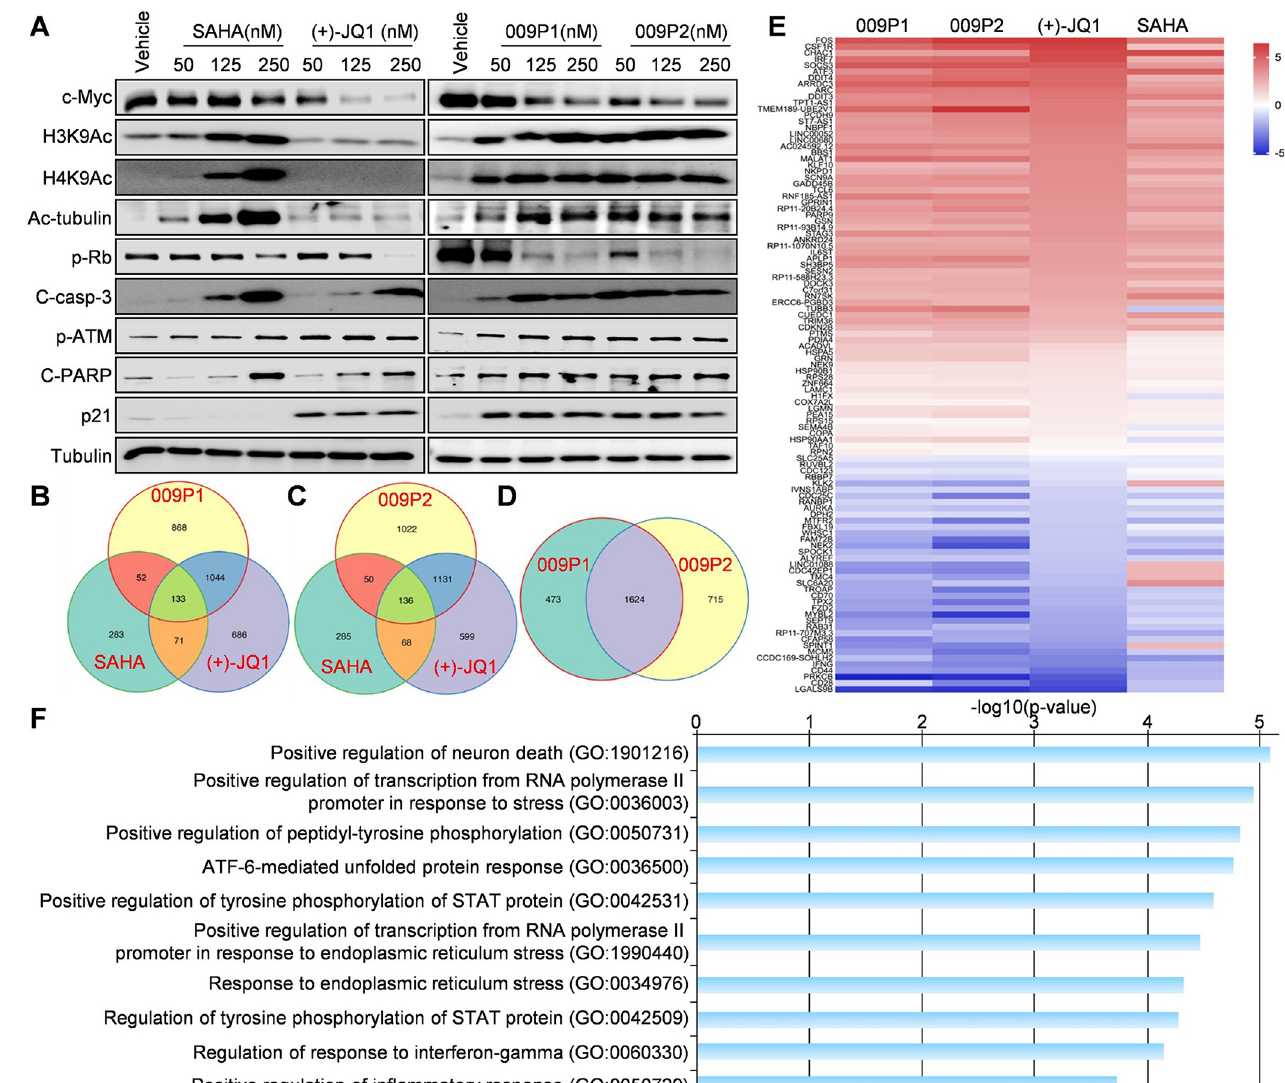
Fig 6. Molecular mechanisms for anti-PEL activities of dual inhibitors 009P1 and 009P2. ( A ) BCBL-1 cells were treated with indicated concentrations of compounds for 48 h, then protein expression was measured by Western blot. ( B-D ) The intersection analysis of significantly altered genes (expression change � 2-fold and p < 0.05) identified by RNA-Sequencing from 009P1-, 009P2-, (+)-JQ1-, or SAHA-treated BCBL-1 cells, respectively. ( E-F ) Heat map and enrichment analysis of genes commonly altered in 009P1-, 009P2-, (+)-JQ1-, and SAHA-treated BCBL-1 cells.